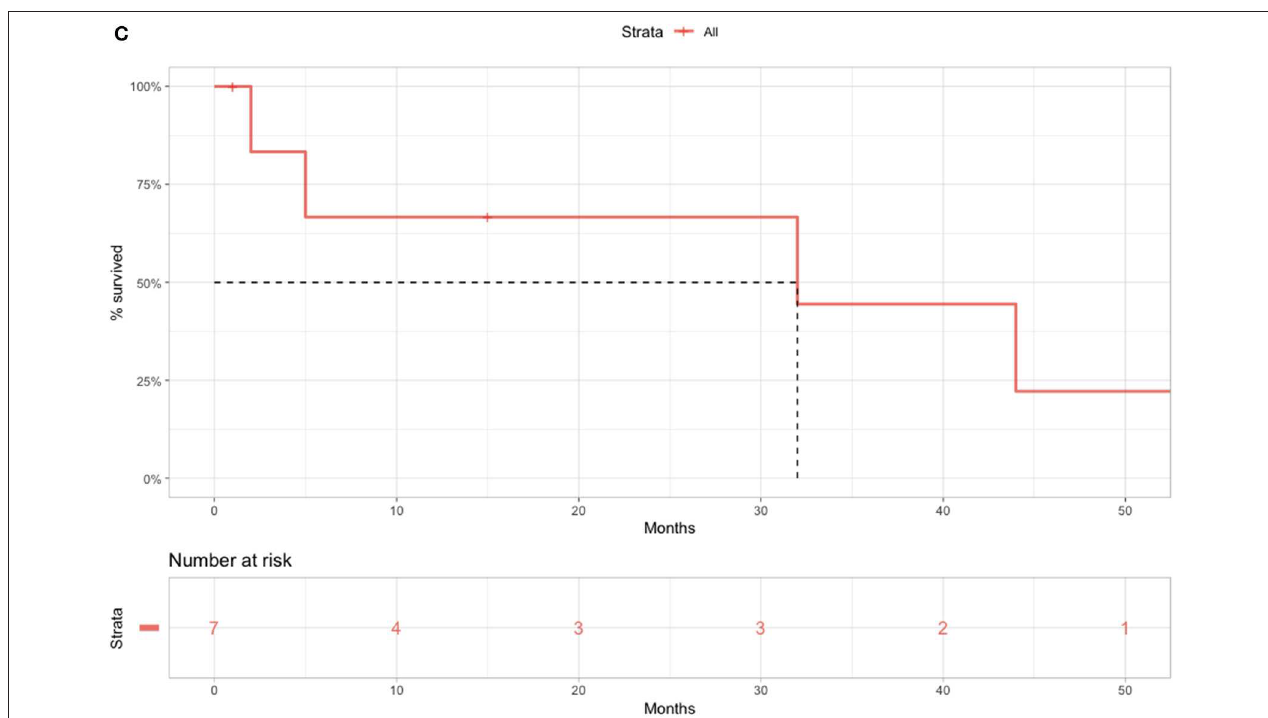
FIGURE 3 | Real-life setting data on the use of blinatumomab for B-cell ALL. (A) Overall treatment of the patients before blinatumomab. (B) OS for patients treated with blinatumomab in Romania. (C) RFS for patients treated with blinatumomab in